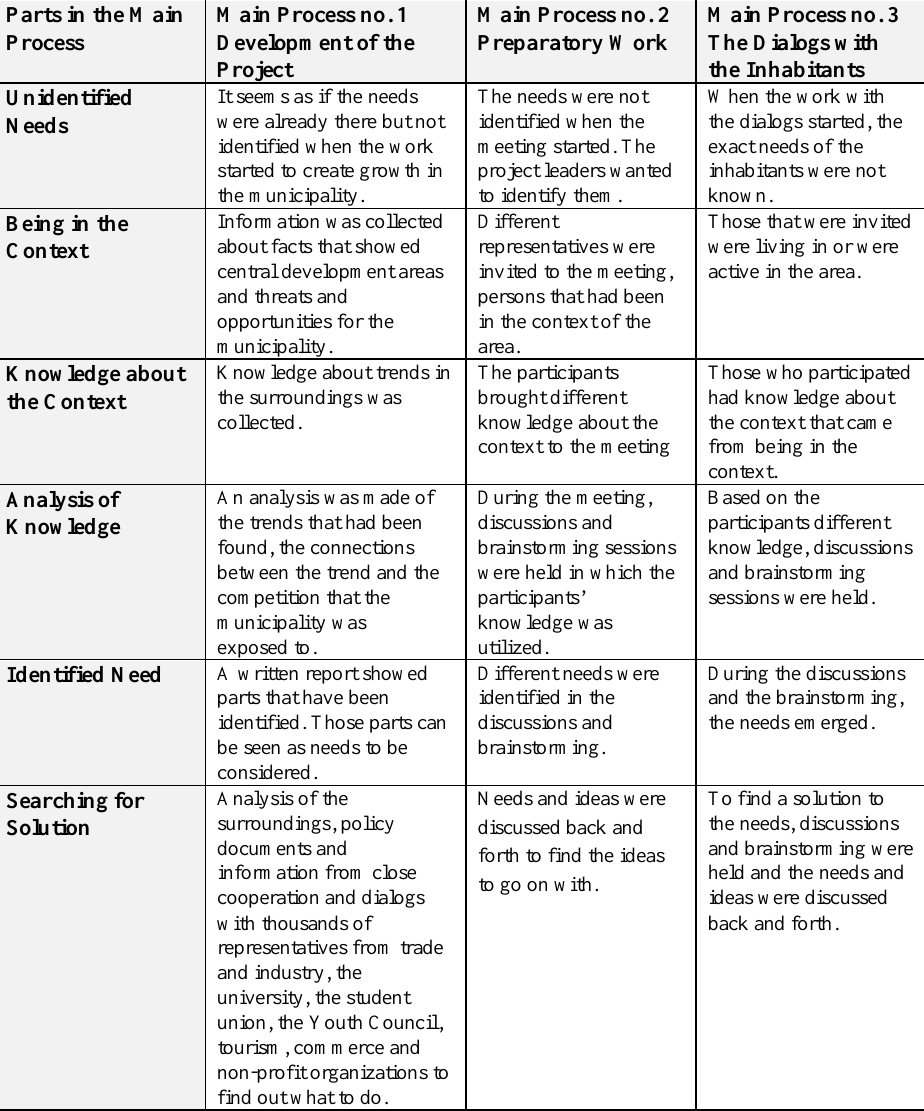
Main Process no. 2 The Dialogs